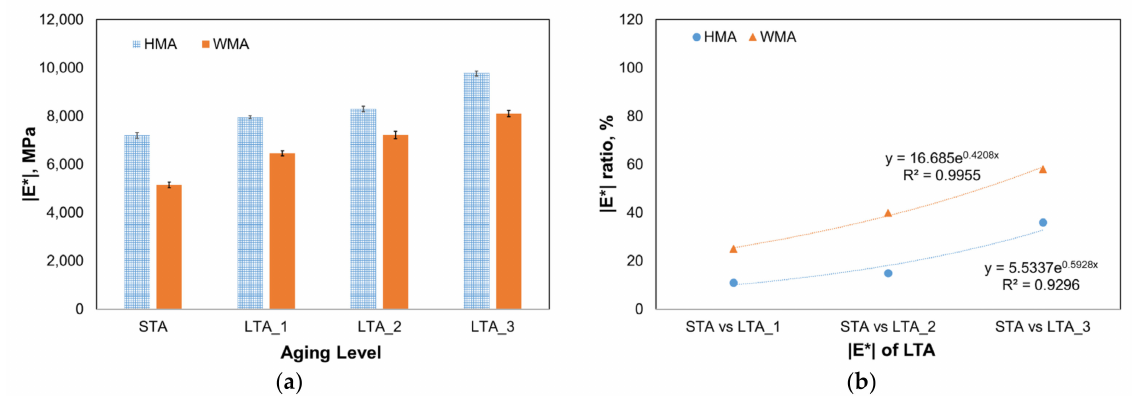
Figure 12. Dynamic modulus of HMA/WMA mixtures for each stage of aging at 20 ◦ C (before moisture damage): ( a ) dynamic modulus and ( b ) rate of